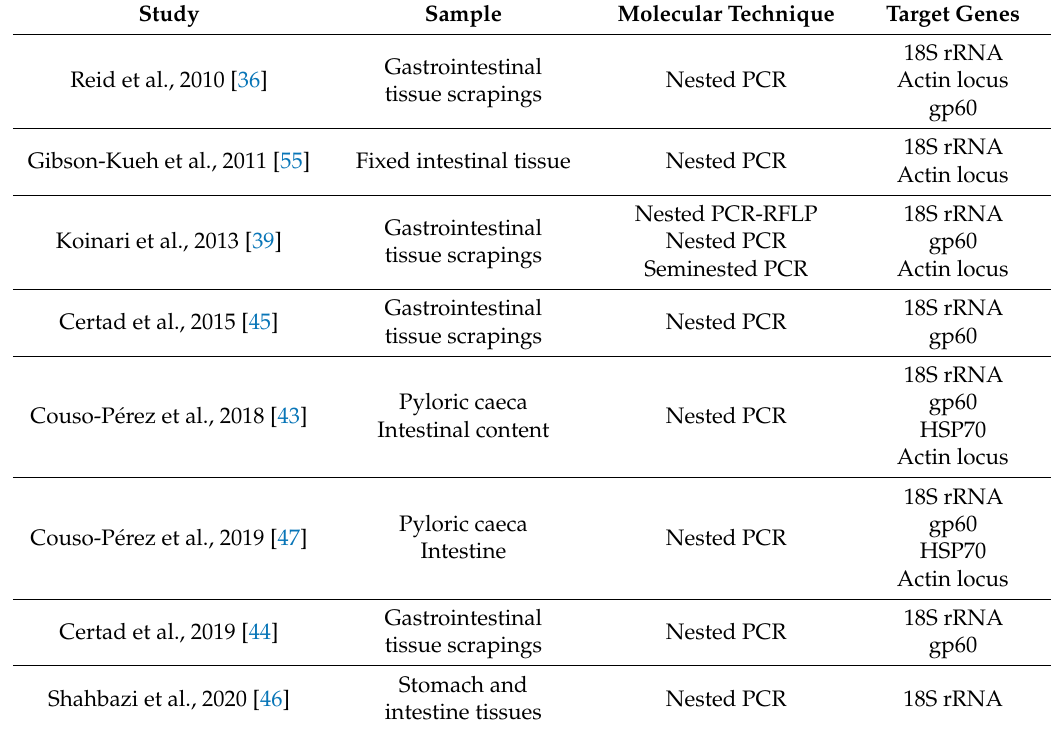
Table 4. Comparative table on the molecular methods (technique and target genes) used for identifying zoonotic Cryptosporidium species in fish